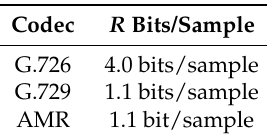
Table 5. Codec rates to achieve PESQ/mean opinion score (MOS) of 4.0 for “We were away . . . ” [6]. AMR, adaptive